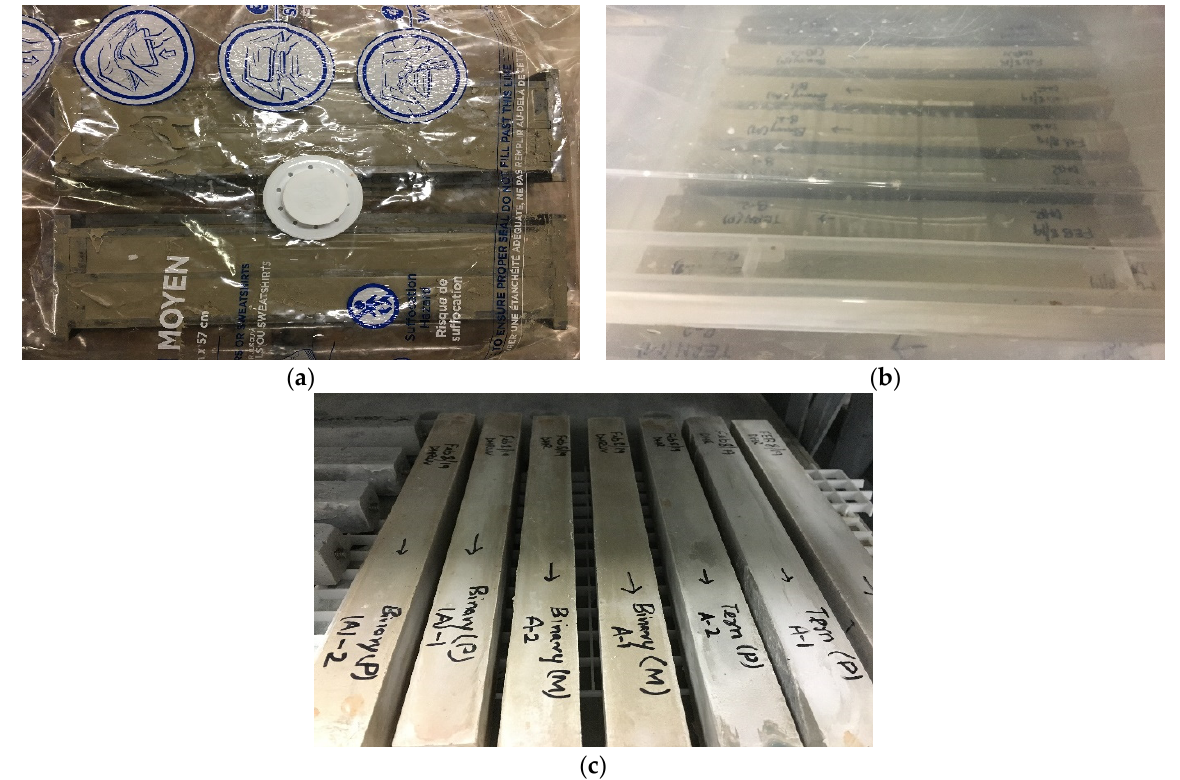
Figure 3. Curing regimes for drying shrinkage prisms: ( a ) airtight plastic bag storage for the first 24 h, ( b ) water storage, ( c ) air/ambient storage.